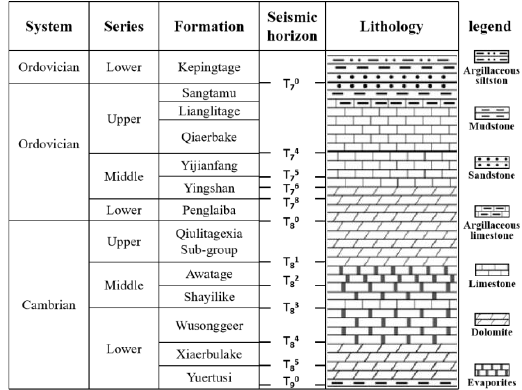
Figure 3. A chart of the Shunbei Cambrian-Ordovician stratigraphy, the seismic horizon, and the lithology.